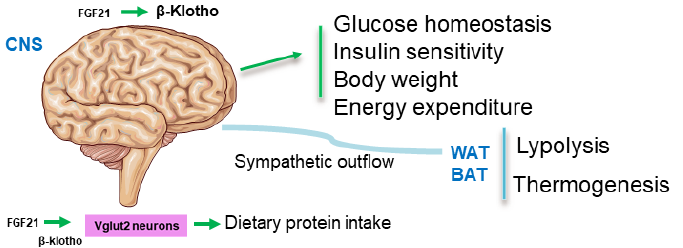
Figure 2. FGF21/ β -Klotho interactions in the CNS in metabolic control: FGF21 required β -klotho- containing receptor complexes in neurons to decrease body weight and circulating glucose and insulin concentrations, to induce energy expenditure and to signal WAT and BAT by SNS activation.